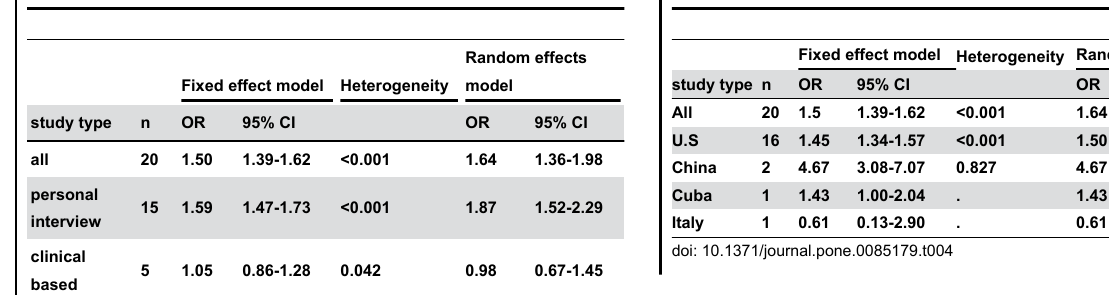
Table 2. Pooled Odds Ratio for prostate cancer and prostatitis by study design.